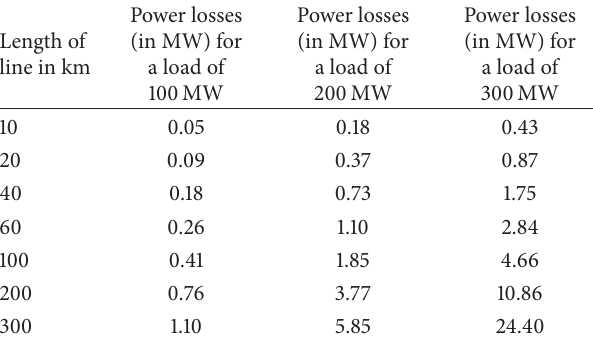
Table 3: Simulated results of power losses on 330 kV single circuit of the Nigerian transmission